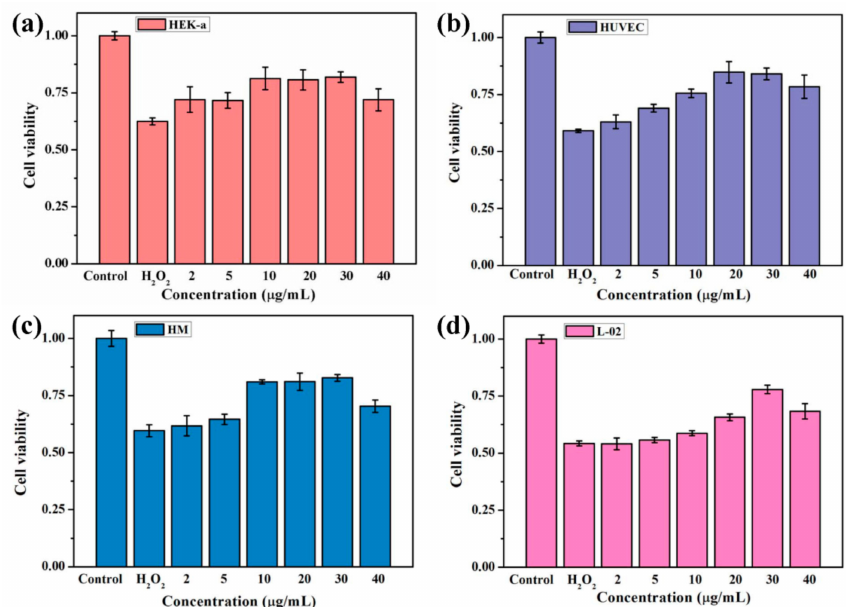
Figure 7. Cell viability of ( a ) HEK-a, ( b ) HUVEC, ( c ) HM and ( d ) L-02 cells that were pre-treated with di ff erent concentrations of C 60 -PDA-GSH nanoparticles separately for 3 h before exposure to 1 mM H 2 O 2 for 1 h. The control groups were the cells treated only with